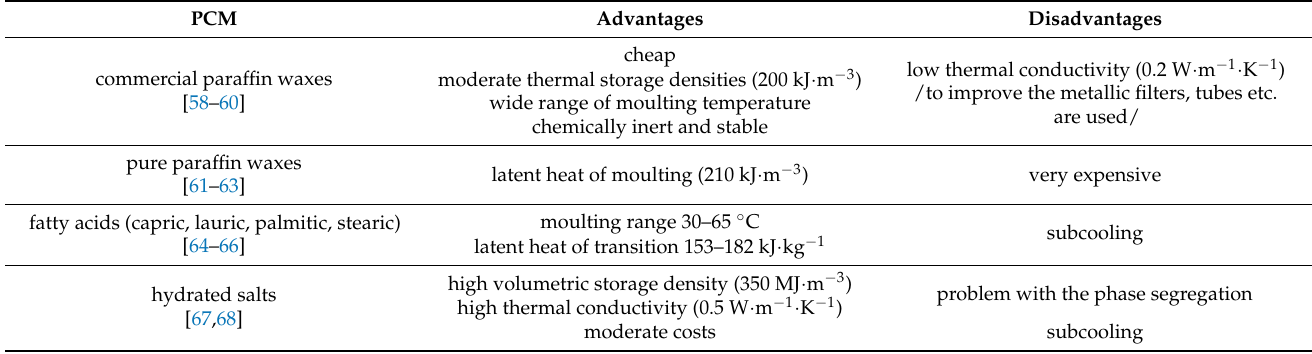
Table 1. Advantages and disadvantages of PCM.